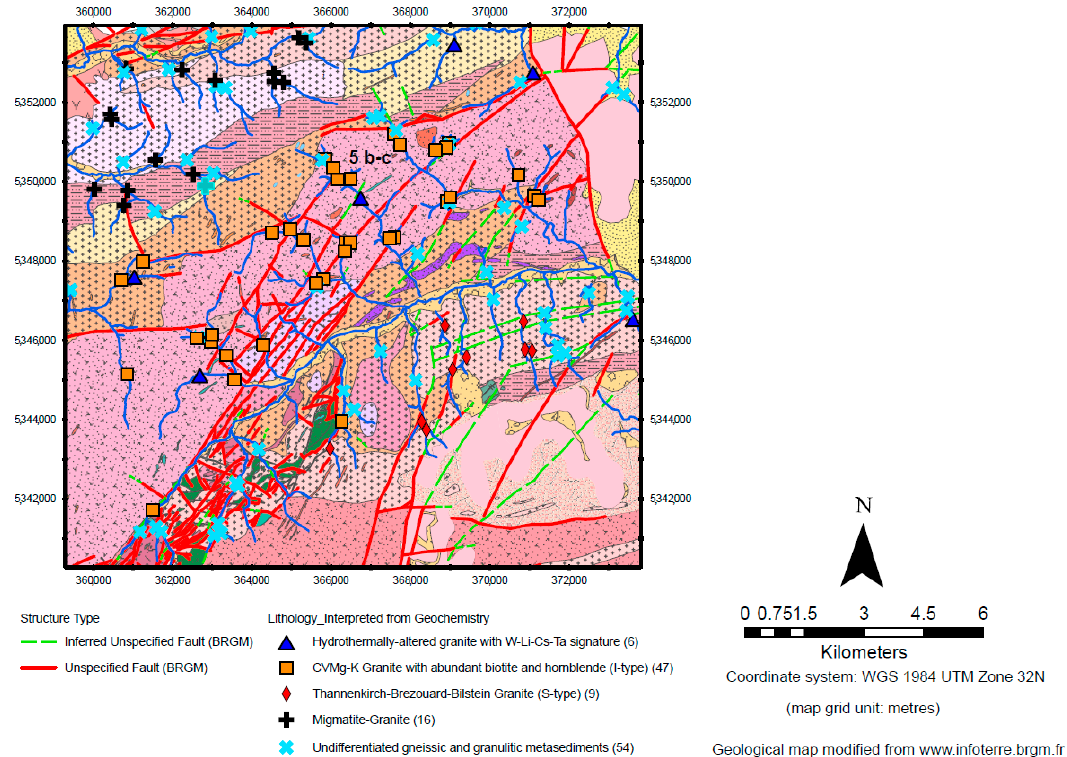
Figure 6. Lithologies interpreted from stream sediment geochemistry on modified Bureau de Recherches Géologiques et Minières (BRGM) geological map and structures, modified from Steiner (2019) [29] and BRGM (2019) [79]. The illustrated area covers the SW–NE trending Central Vosges Mg–K (CVMg–K granite), surrounded by highly metamorphic rocks of Paleozoic age. Observed leucogranitic and pegmatitic rocks with visible muscovite and tourmaline (location indicated as 5 b–c) along with interpreted “hydrothermally-altered granites with W–Li–Cs–Ta signature” are principally located along SW–NE orientated fault systems in the CVMg–K granite.